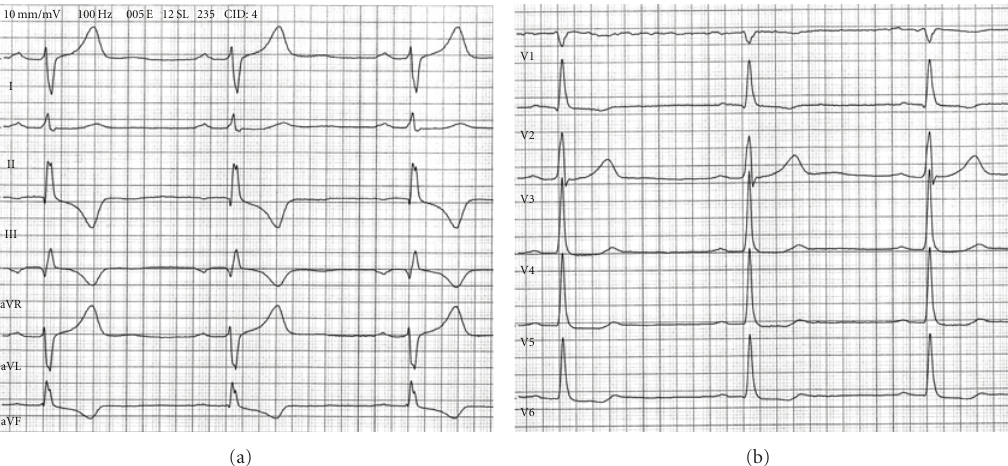
Figure 1: Electrocardiogram with right axis deviation, in leads I and aVL rS complexes with very deep S waves and prominent T waves not usually seen in these leads and more typical of V2 lead. Note the di ff erent direction of the ORS complex in lead I and leads V5 and V6.